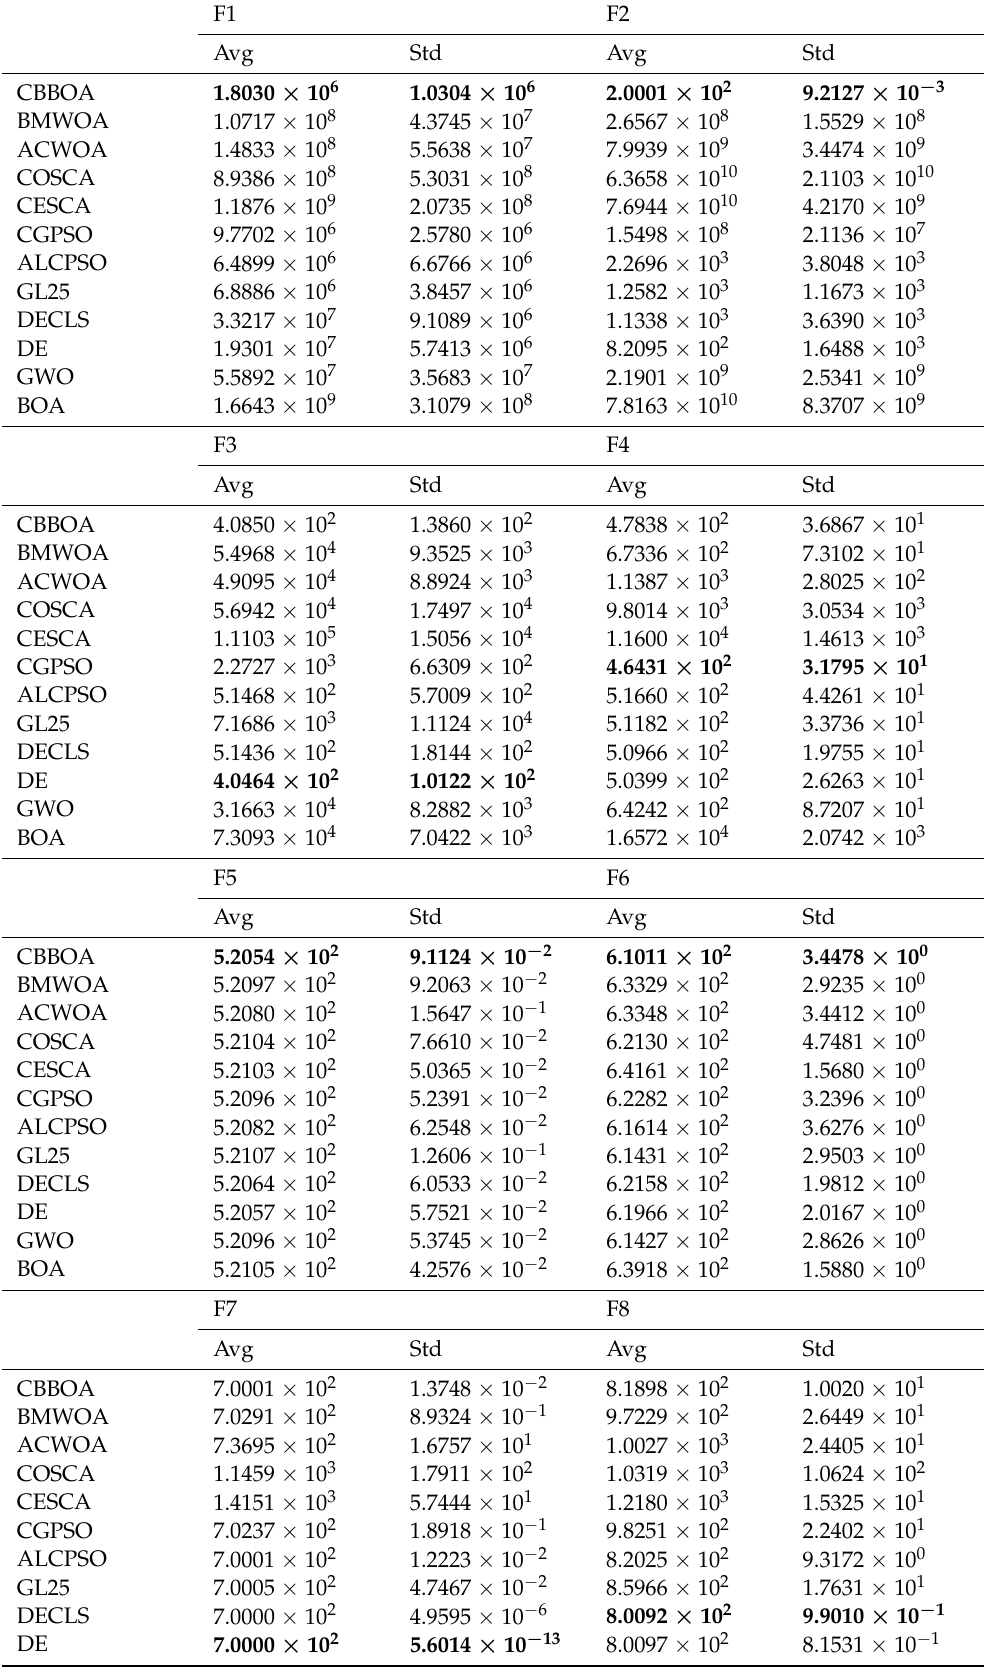
Table A2. Comparison results of CBBOA and other